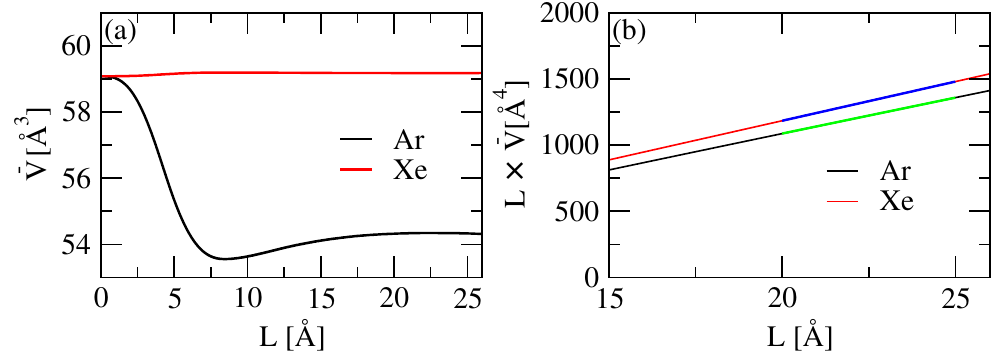
Figure 4. ( a ) Partial molar volumes ¯ V Ar (black) and ¯ V Xe (red) from the KBI as a function of L , at T = 85 K and x Ar = 0.02. ( b ) Plot of L × ¯ V Ar and L × ¯ V Xe and linear fits (green and blue